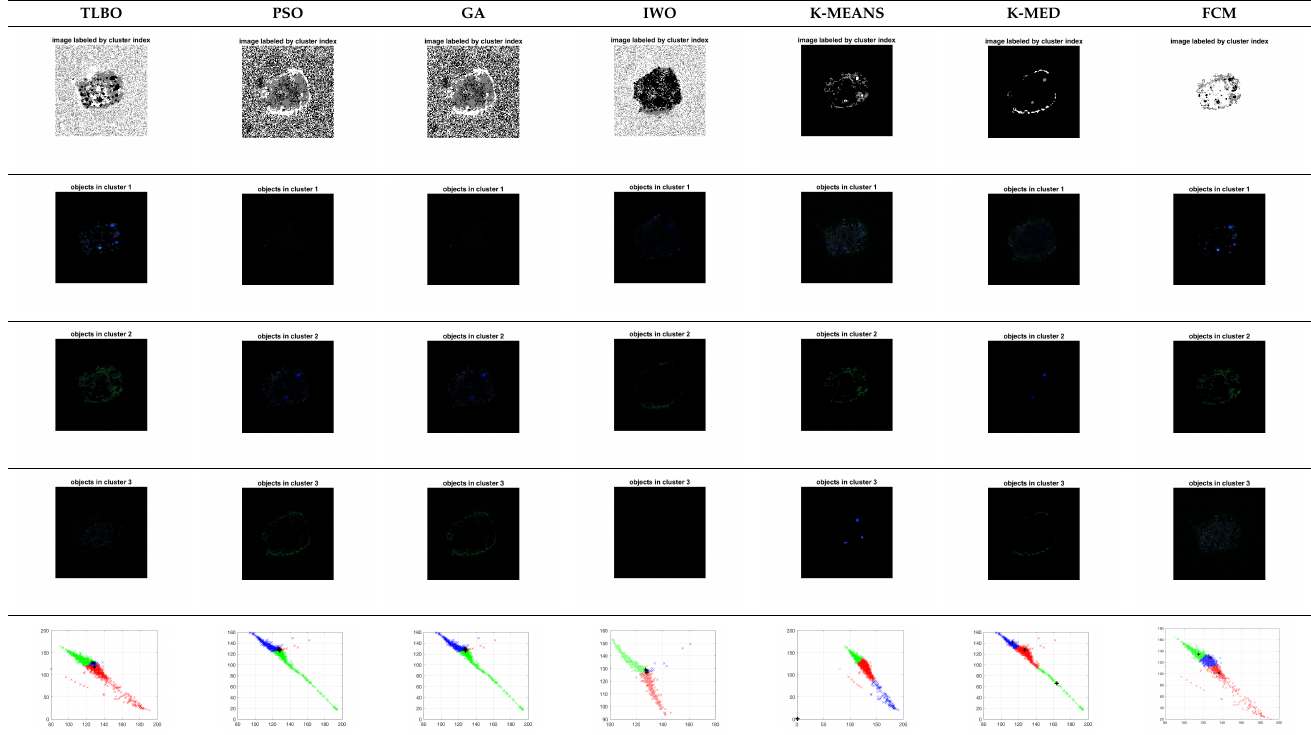
Table 3. Comparative analysis of visual TLBO results with other clustering algorithms for 2:0.5 ratio image of Figure 1a.